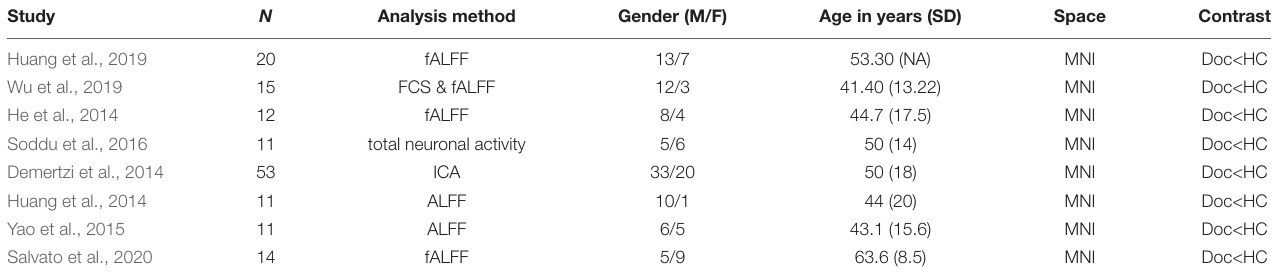
FIGURE 1 | Flowchart of literature screening. TABLE 3 | Subject demographic in included